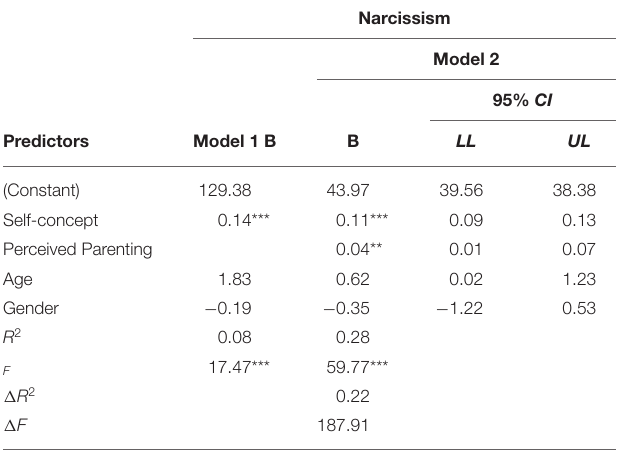
TABLE 9 | Mediating effect of involvement (perceived) between likeability (self-concept) and authority (narcissism) ( N = 628).